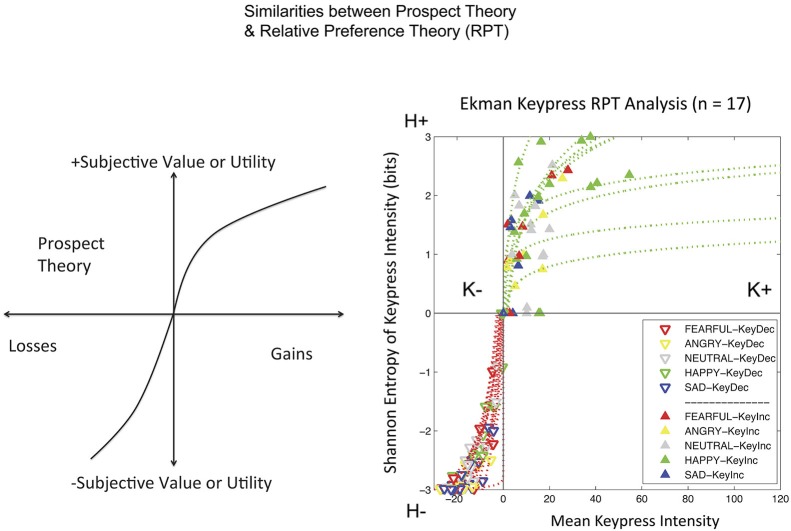
Relative Preference Graphs. The output of the keypress paradigm is shown for 17 subjects on the right. The variable K stands for the mean number of keypresses made for category of picture viewed (mean viewtime per category can also be substituted to produce comparable results). K can be interpreted as the effort expended to approach (+ keypresses) or avoid (keypresses) stimuli, and approximates wanting. The variable H stands for the Shannon entropy (information or uncertainty related to making a choice) for each category of picture. It can be interpreted as representing memory about the uncertainty related to making choices over this stimulus set. The approach graph is in green and the avoidance graph is in red. On the left is shown a schema for prospect theory (Kahneman and Tversky, 1979) to emphasize the similarity, despite different variables, between the two theoretical frameworks of prospect theory and relative preference theory (Breiter and Kim, 2008; Kim et al., 2010). Both show an increased slope for negative or avoidance responses relative to positive or approach responses.